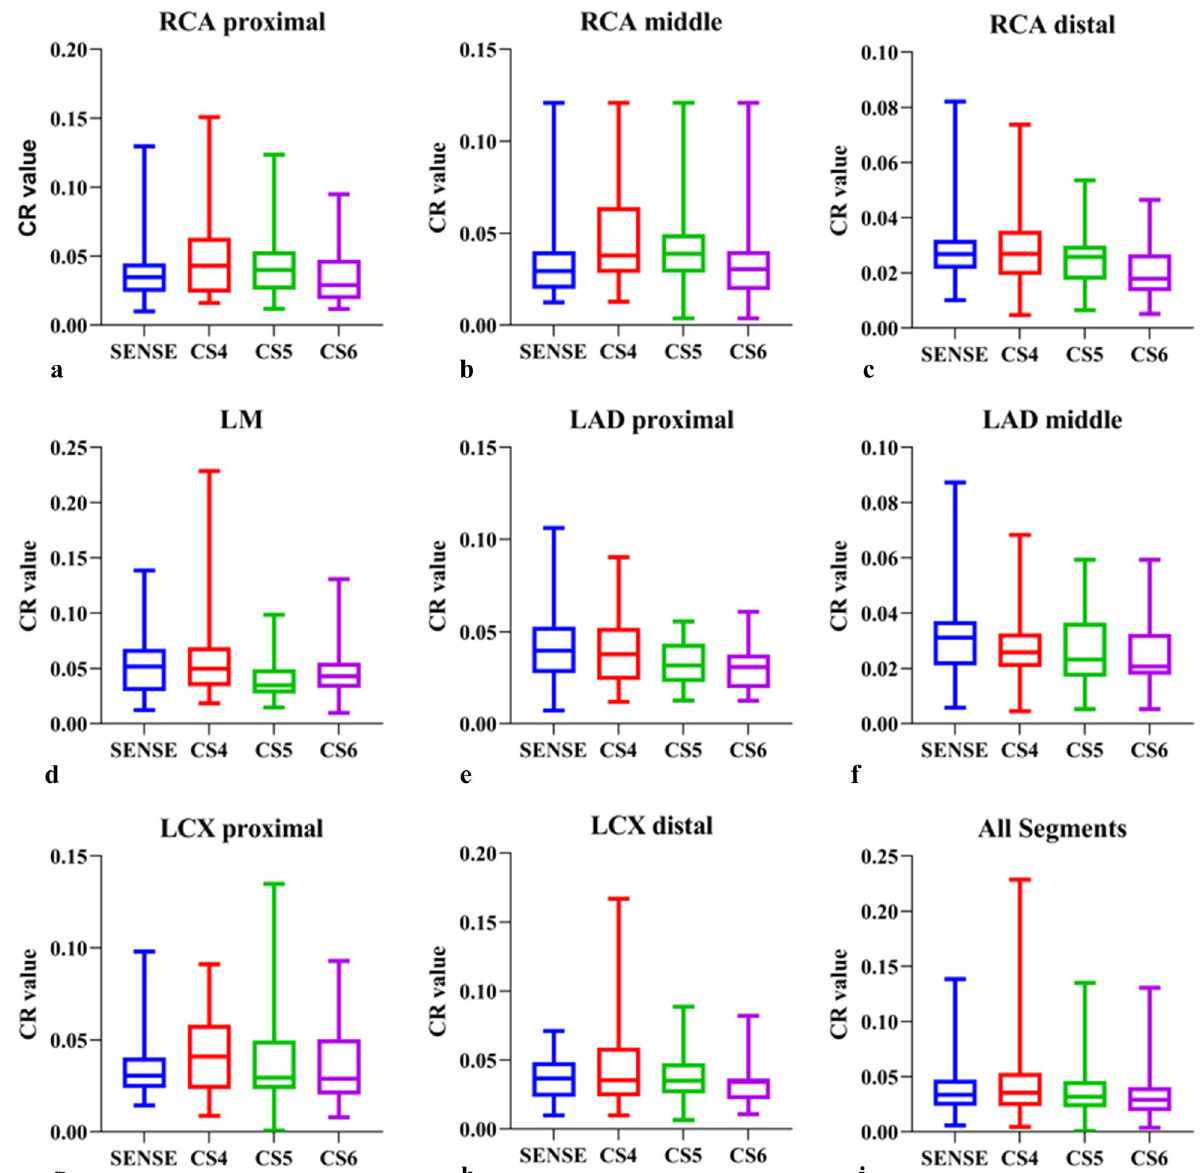
Fig. 10 The CR values of coronary artery segments ( a–h ) and overall artery segments ( i ). In comparison to the SENSE sequence, the CR values for the RCA pro, the RCA mid, and the overall segments were higher in the CS4 sequence. From the CS6 sequence, the mean CR was lower than from the SENSE sequence. The CS5 and SENSE sequences did not show any statistically significant